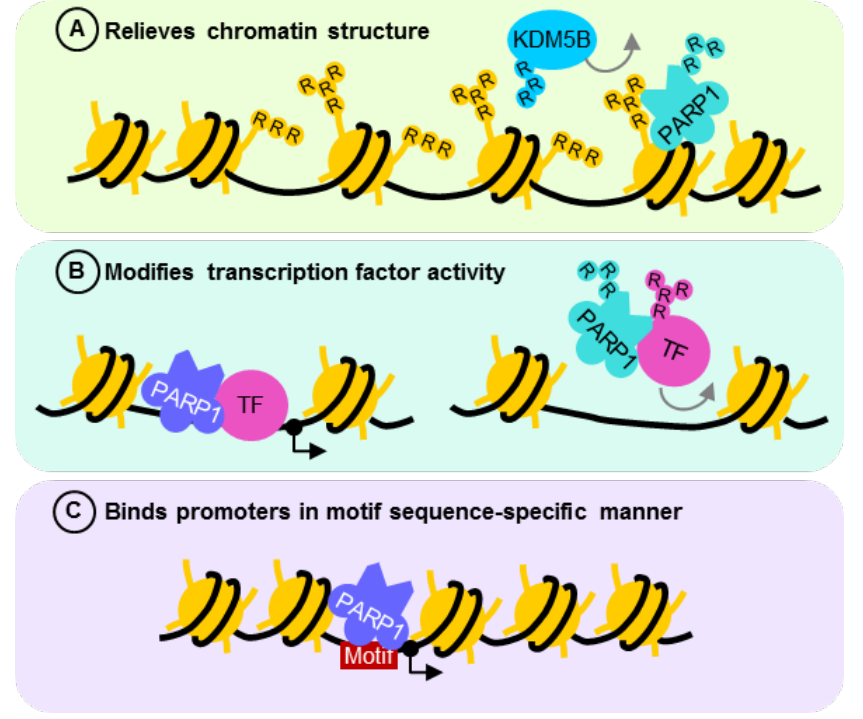
Figure 3. The role of PARP1 in transcriptional regulation. (A) PARP1 relieves and maintains an “open” chromatin structure by ADP-ribosylation of histones or preventing the action of histone demethylase KDM5B. (B) PARP1 forms functional complexes with transcription factors such as NF  B, altering their activity depending on its state of posttranslational modification. This interaction need not activate or require PARP1 enzyme activity, although when stimulated, ADP-ribosylation usually reduces the affinity of the complex for DNA cis elements. The effect of PARP1 on transcription in both cases is dependent on the type of binding partner and nature of promoter element recognized. (C) PARP1 acts as a transcription activator or repressor by binding its recognition motif. Grey arrows are repulsion from DNA or chromatin. R—ADP-ribosylation; TF— transcription